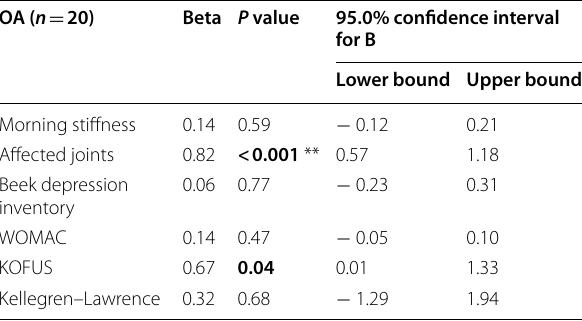
Table 6 Regression analysis for the prediction of the Athens Insomnia scale grading in OA